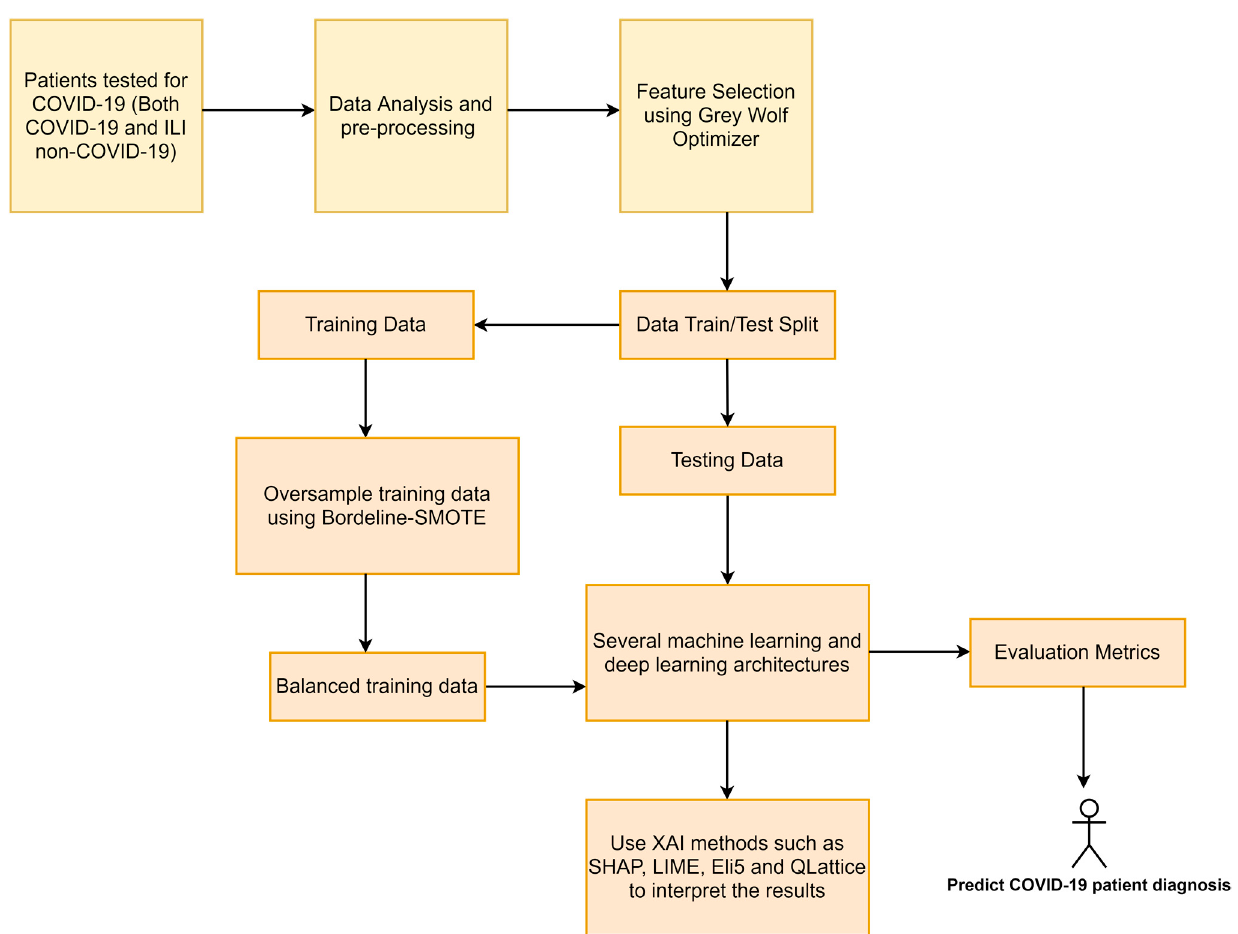
Figure 4. Machine learning pipeline to diagnose COVID-19 using clinical markers.